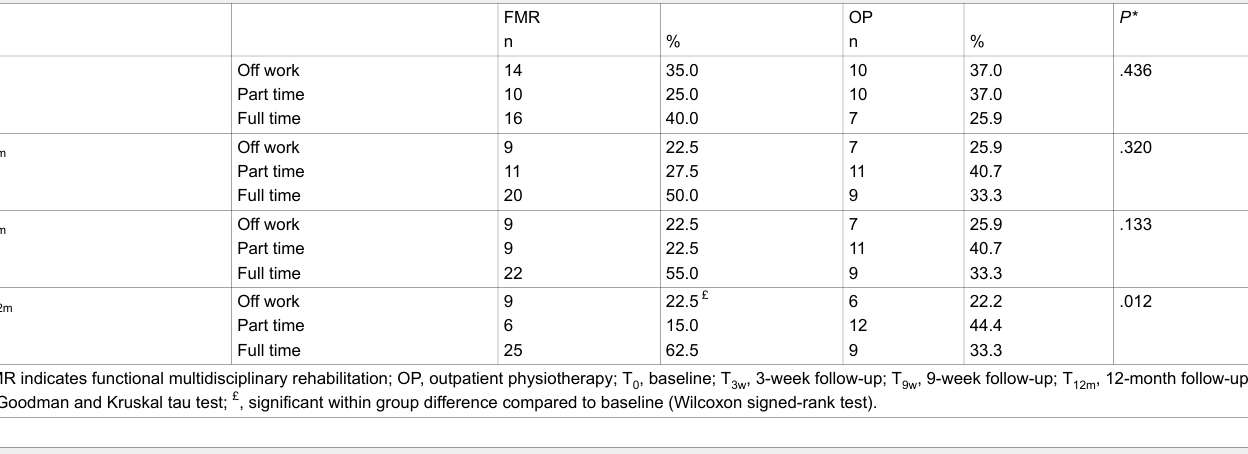
Table 3: Secondary outcomes at baseline and after functional multidisciplinary rehabilitation or outpatient physiotherapy. SFS